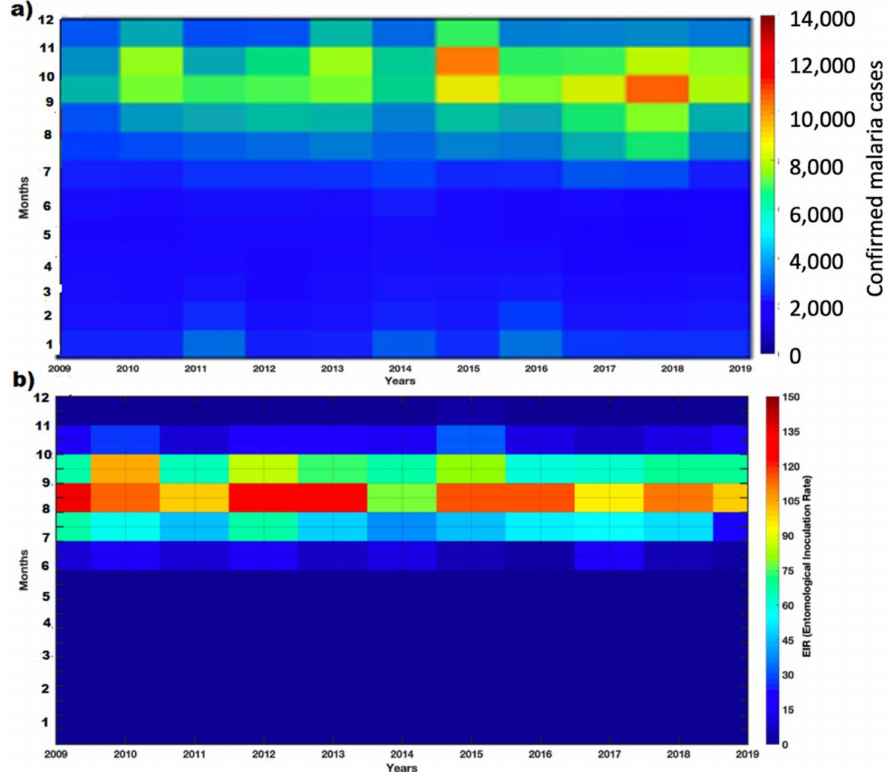
Figure 8. Intra- and interannual variability of malaria cases and simulated malaria parameter (EIR in